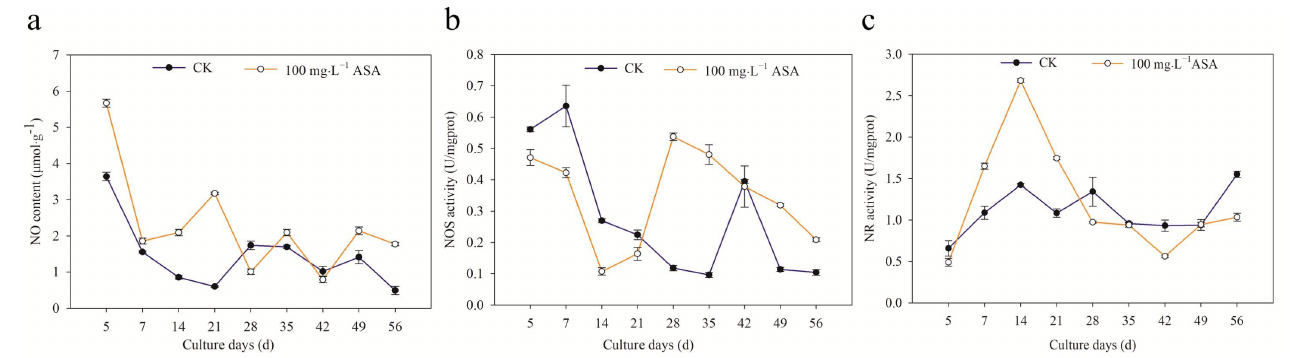
Figure 7. Effects of 0 and 100 mg · L − 1 ASA treatments on NO content, NOS activity, and NR activity during somatic embryogenesis of Fraxinus mandshurica provenance 3. The x -axis represents the culturing days, and the y -axis represents the NO content ( a ), NOS activity ( b ), and NR activity ( c ). Error bars show the standard error of the mean.